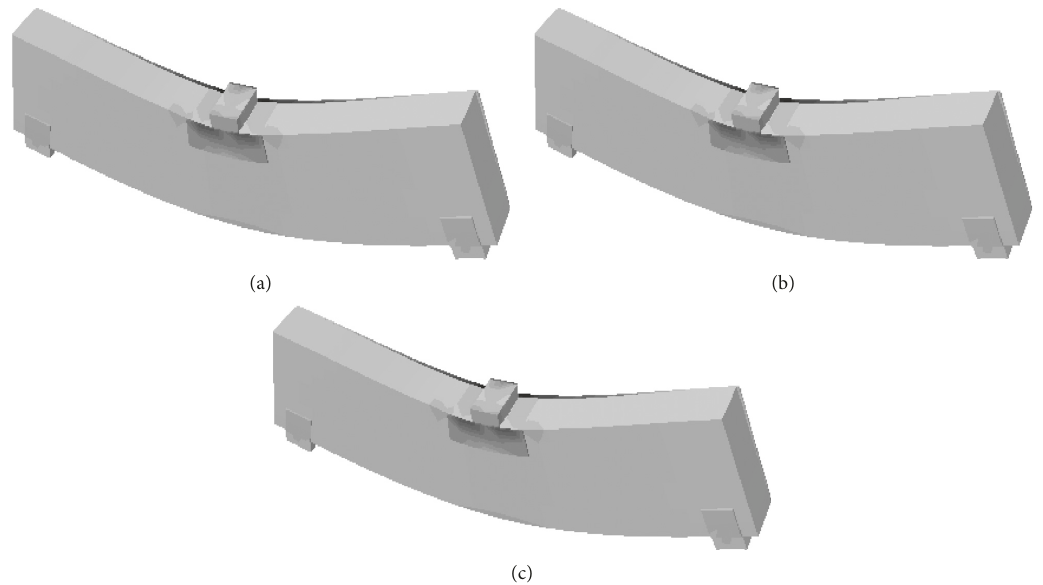
Figure 14: Deformation figure of composite slab under different stud spacings: (a) 150mm, (b) 250mm, and (d)